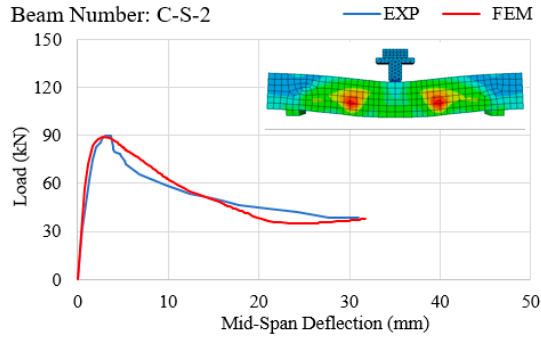
Figure 18. Load vs. mid-span deflection for C-S-2.